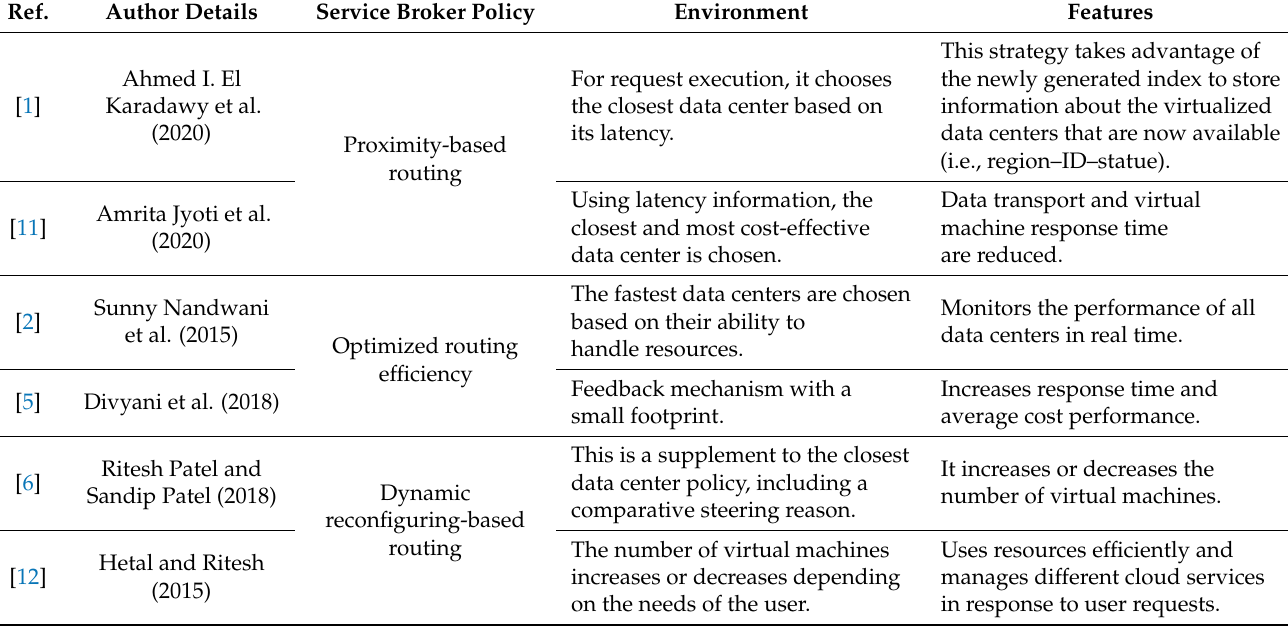
Table 4. Comparative analysis of cloud service broker policy.